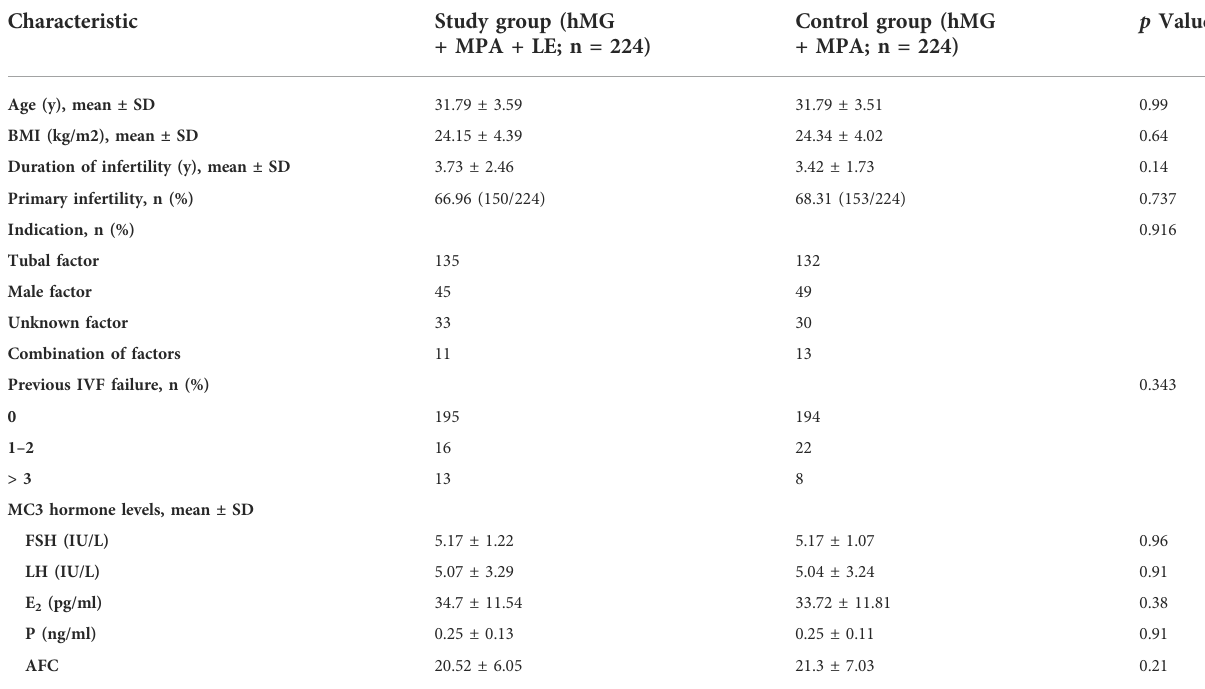
TABLE 1 Baseline characteristics of women undergoing IVF/ICSI.